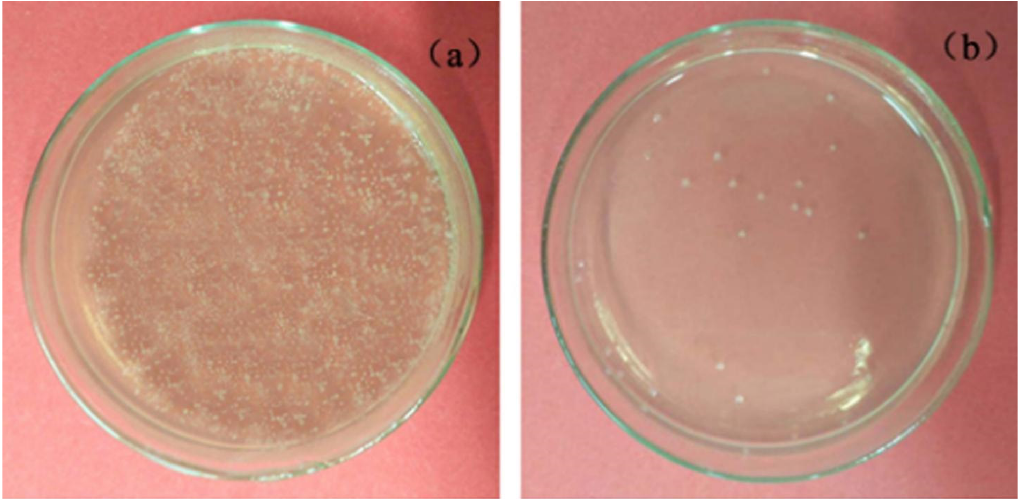
Figure 6. S. aureus bacterial colonies on di ff erent samples after a 12 h incubation. ( a ) NPSS, ( b ) Cu/NPSS. Table 1. The bacterial test results for the Cu/NPSS sample. Strain Bacterial Reduction